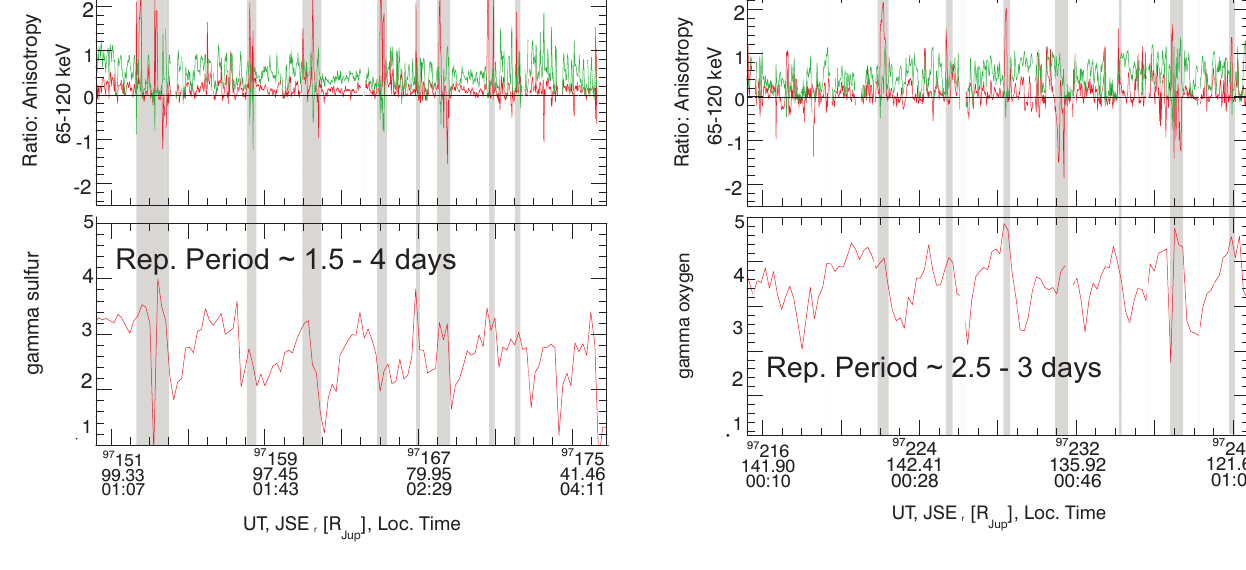
Fig. 3. Format as in Fig. 2. The time interval DOY 150, 00:00 UT to DOY 177, 00:00UT in 1997 (orbit G8) is shown.